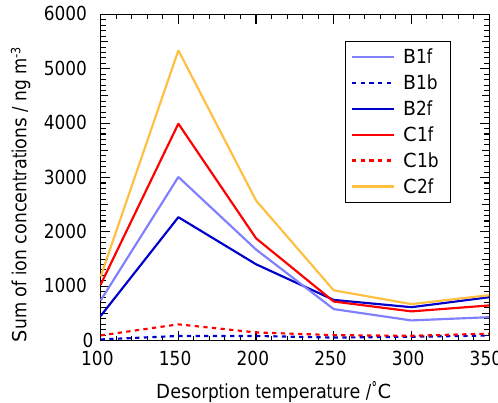
Figure 2. Sum of mass concentrations of desorbed SOA filter ma- terial from α -pinene ozonolysis, as detected by PTR-MS. The con- centrations of all detected ions were summed for each desorption temperature. Full lines represent front filters, dashed lines back fil-